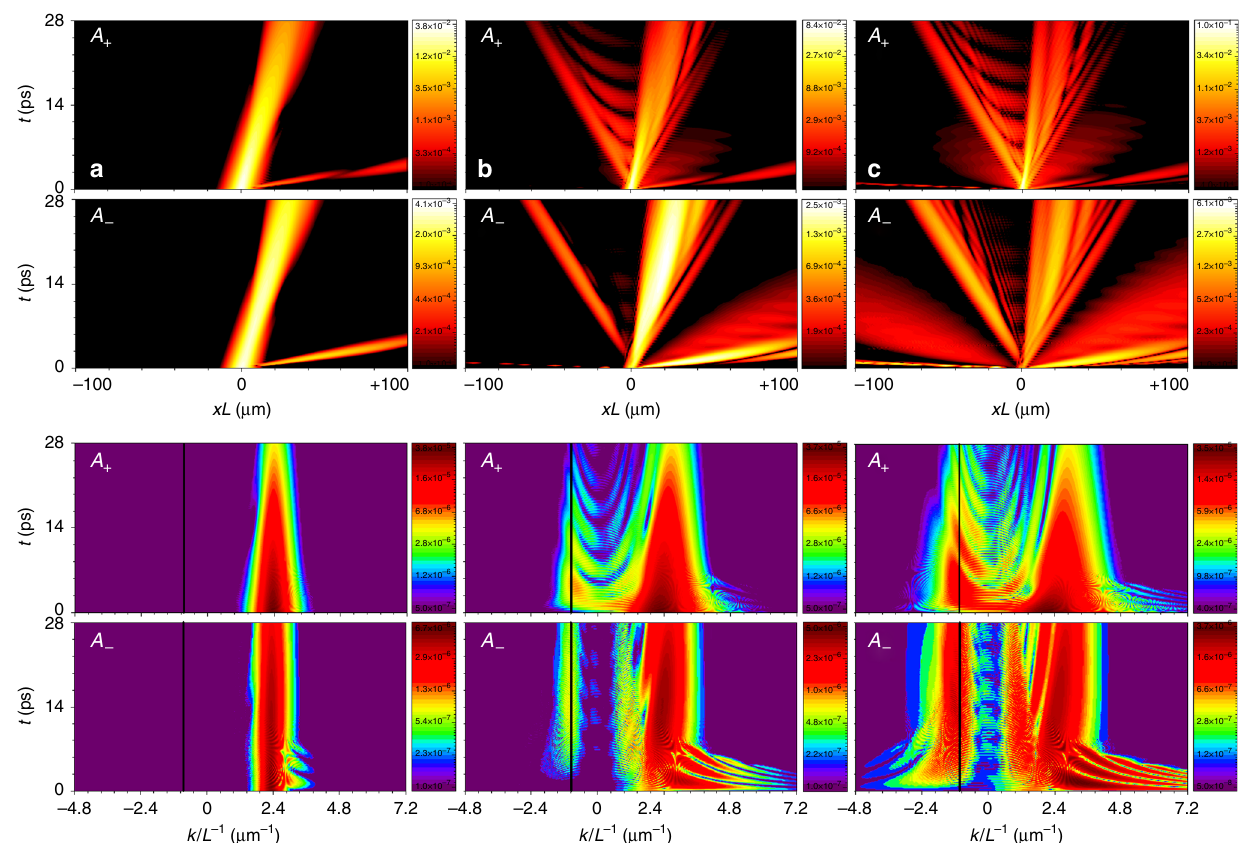
Fig. 4 Emission of the backward Cherenkov radiation. Results of the 2D modelling of Eqs. (1) – (4) showing evolution of the quasi-solitons and of the backward-emitted Cherenkov radiation with the negative momentum and negative group velocity. The parameters are δ = − 0.29 ( ε = − 1.305 meV) (column a ), δ = − 0.24 ( ε = − 1.08 meV) (column b ), δ = − 0.2 ( ε = − 0.9 meV) (column c ), γ c , e = 0.01. ( x , t )-plots show the space-time dynamics of | A ± ( x , t ) | and ( k , t )-plots show the corresponding evolution of the photon density in the momentum space, all are for y = 0. The waves deviating towards negative values of x in the ( x , t )-plots in columns b and c are the backward Cherenkov radiation. Vertical black lines on the ( k , t )-plots show theoretically